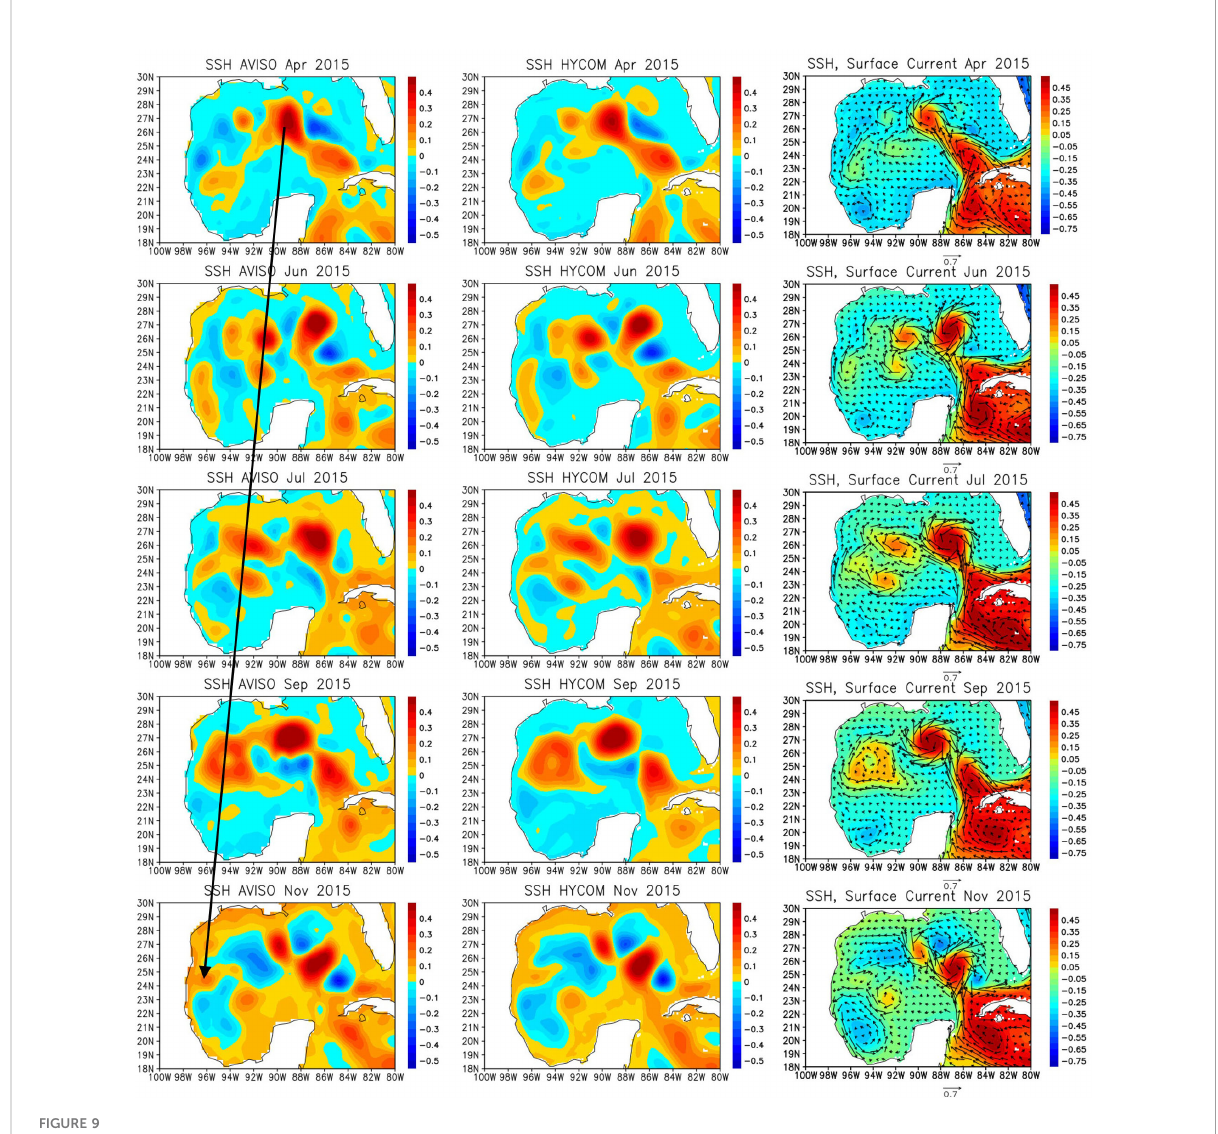
FIGURE 9 Same as Figure 6 except for April, June, July, September, and November